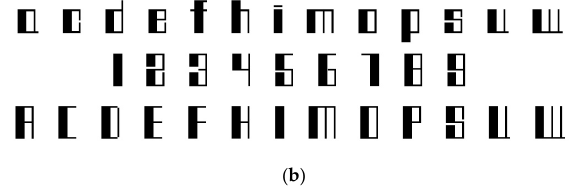
Figure 1. Characters of secure fonts: ( a ) secure symmetrical, ( b ) secure asymmetrical.